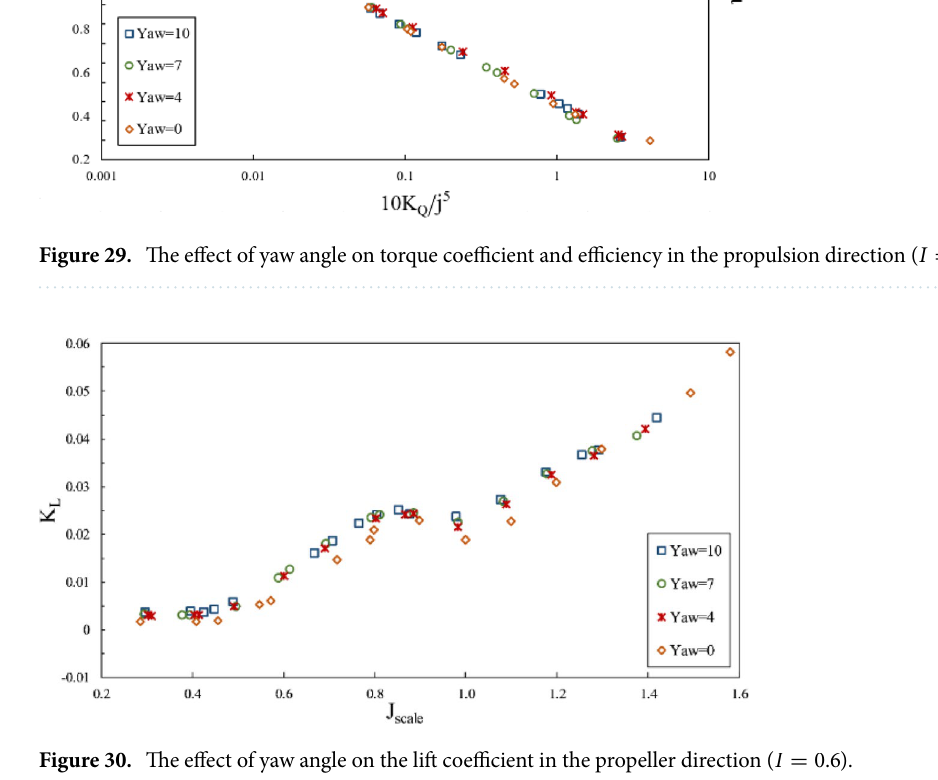
the reduction of the side force on the shaft due to reduced effective pitch of the propeller in line with the flow . Based on comparing the side force and thrust in line with the flow, it can be seen that with the increased yaw